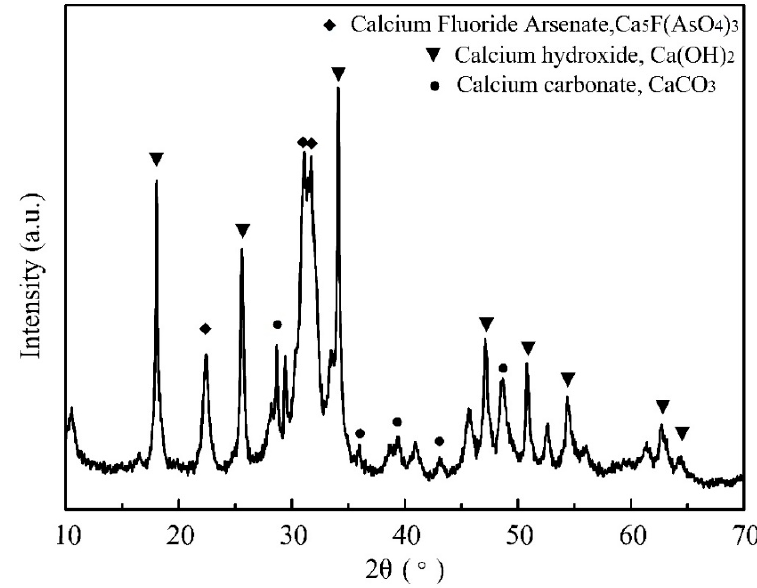
Figure 7. XRD pattern of the precipitate from the causticization process in air.